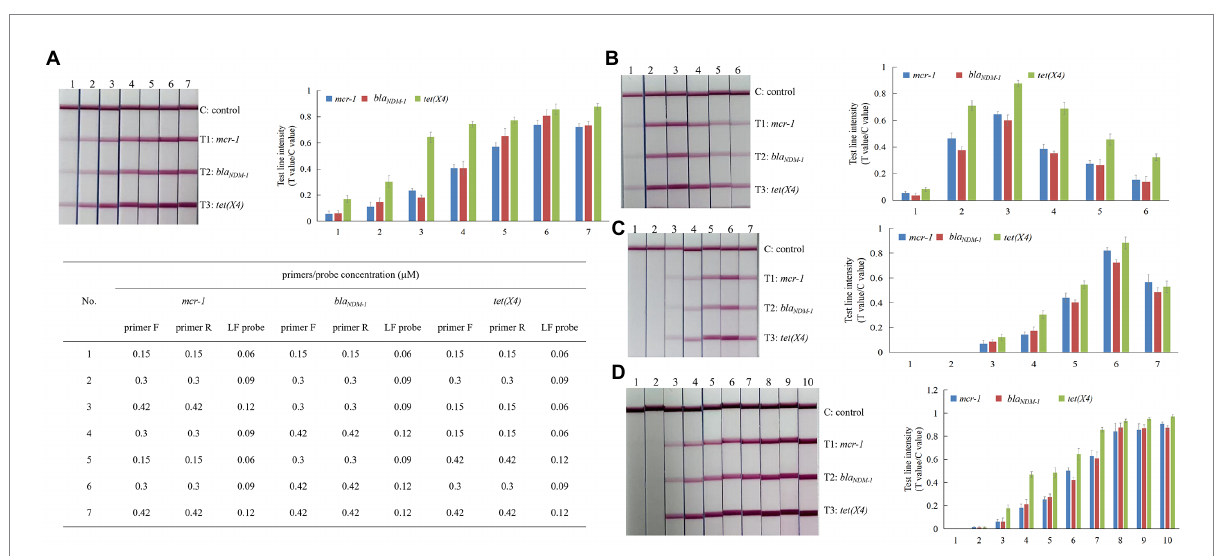
FIGURE 3 Specificity analysis of the triplex RPA-LFD assay. 1: Top10-pUC- mcr-1 + Top10-pUC- bla NDM-1 + Top10-pUC- tet(X4) ; 2: Top10-pUC- mcr-1 + Top10-pUC- bla NDM-1 ; 3: Top10-pUC- mcr-1 + Top10-pUC- tet(X4) ; 4: Top10-pUC- bla NDM-1 + Top10-pUC- tet(X4) ; 5: Top10-pUC- mcr-1 ; 6: Top10-pUC- bla NDM-1 ; 7: Top10-pUC- tet(X4) ; 8: ATCC25922; 9: negative control.